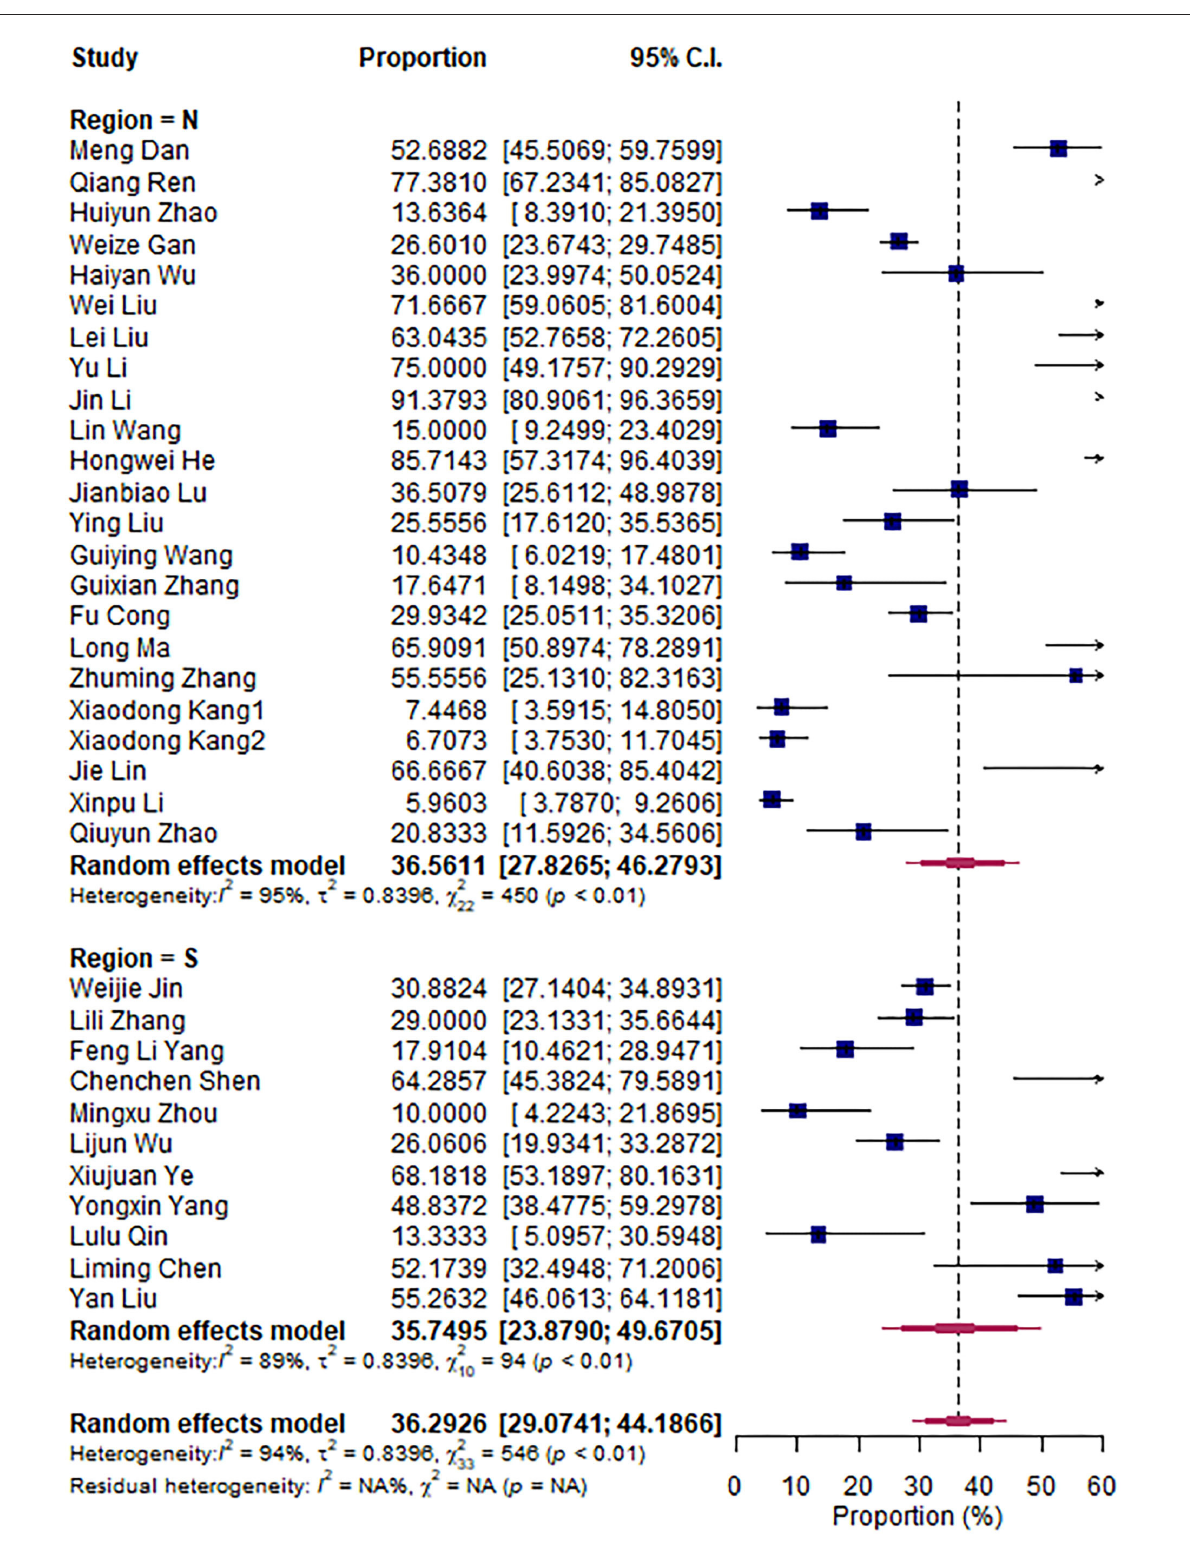
FIGURE3 Prevalence subgroup by